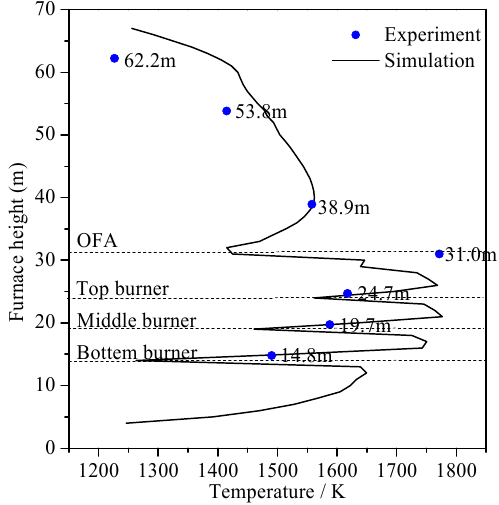
Figure 4. The average temperature within the furnace of the in-situ test and simulation results.